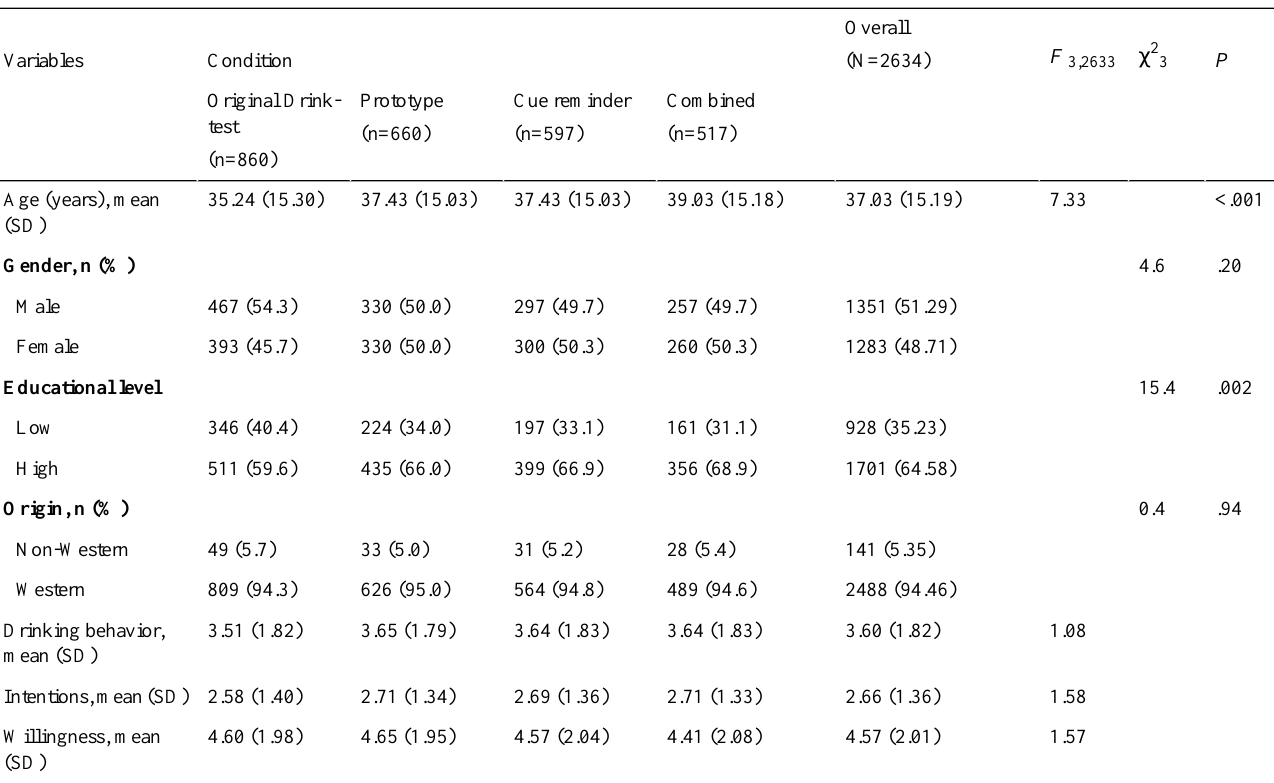
Table 1. Participant characteristics and primary outcome measures at baseline (T1) presenting differences between study